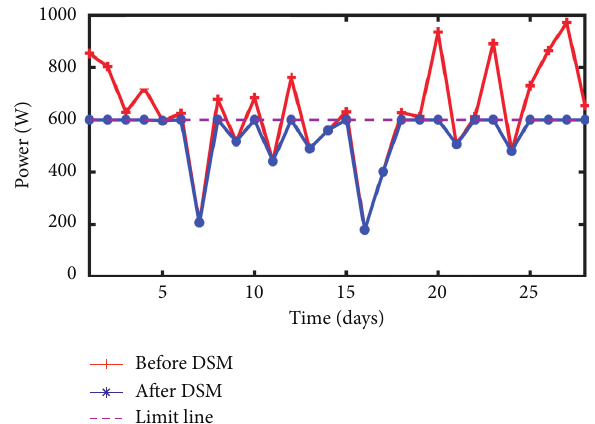
Figure 18: Load profile before and after the implementation of DSM in cluster 10.